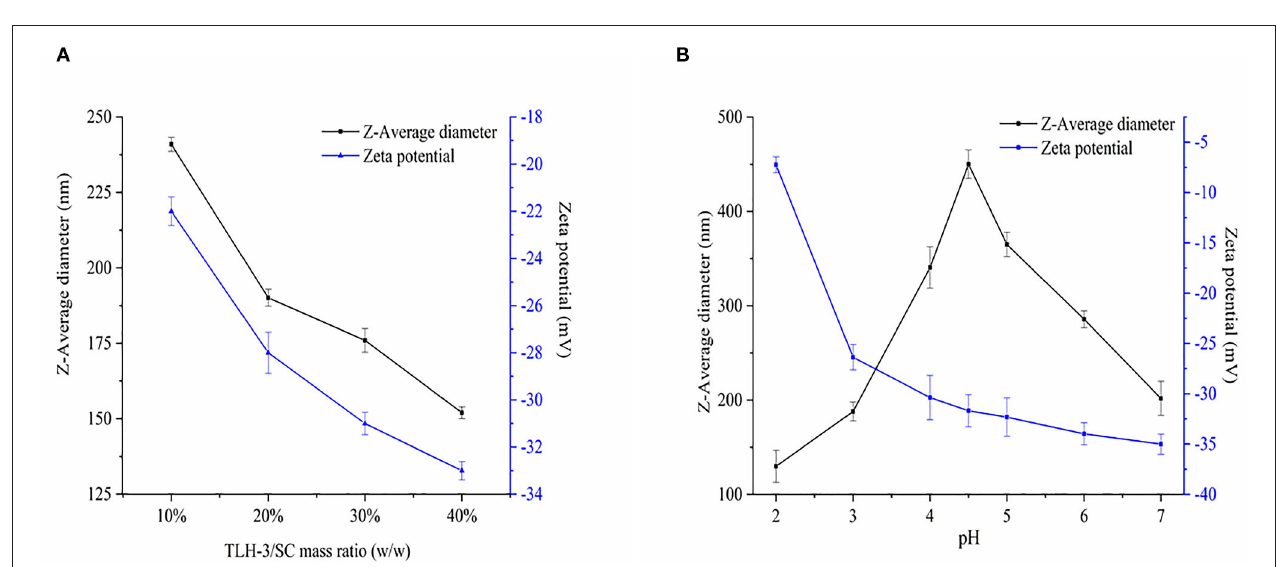
FIGURE 3 | Effects of TLH-3/SC mass ratio (A) and pH (B) on the Z-average diameter, and Zeta potential of TLH-3/SC PEC NPs. Data represent the mean ± standard deviation (SD, n = 3).